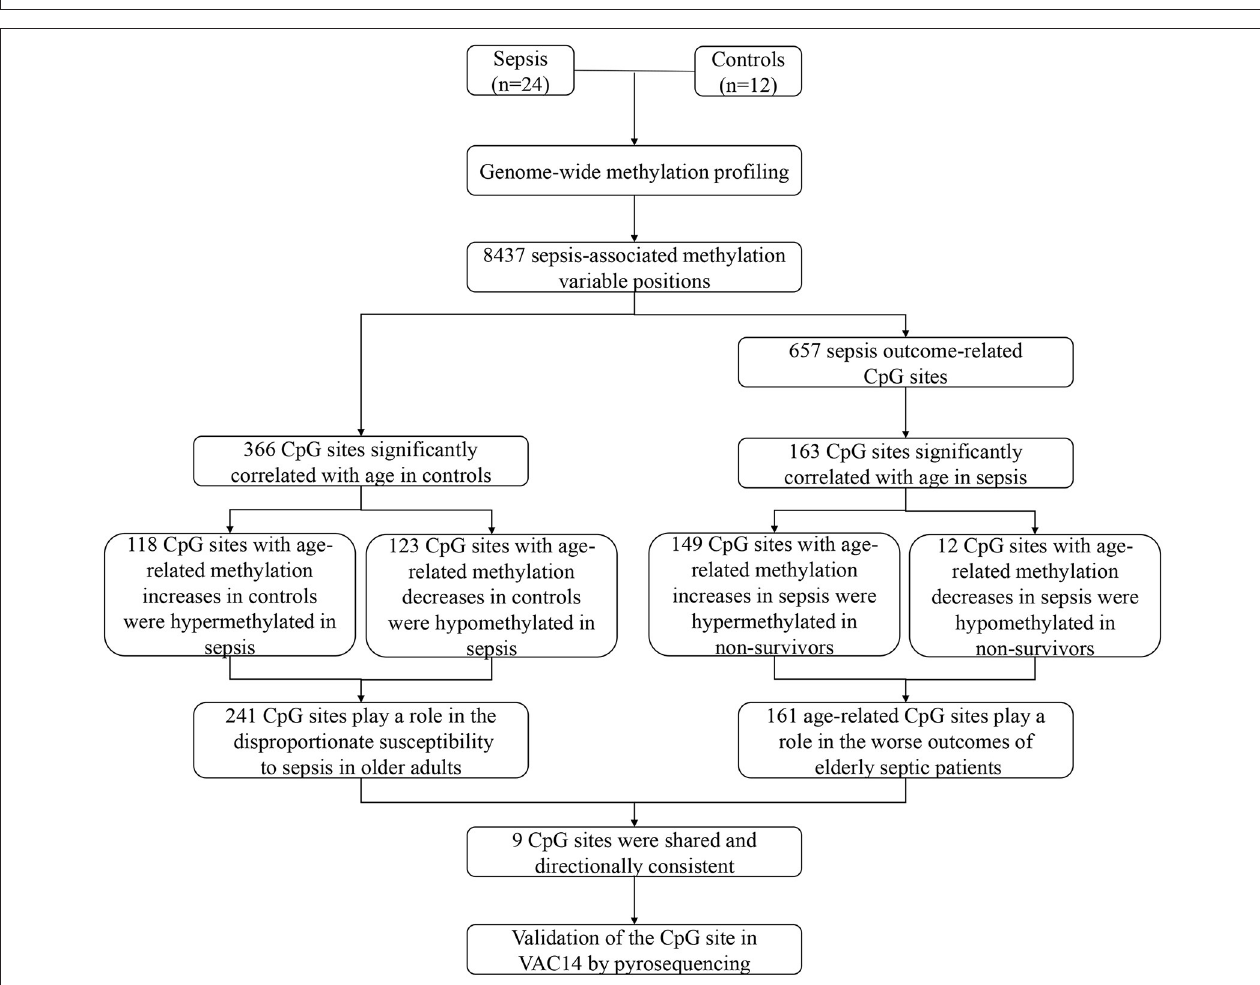
FIGURE 7 | Schematic of